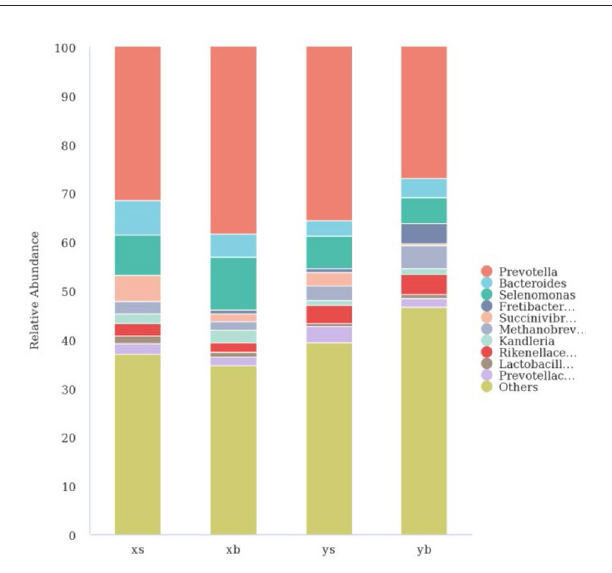
FIGURE3 The taxonomic composition distribution in samples in the genus